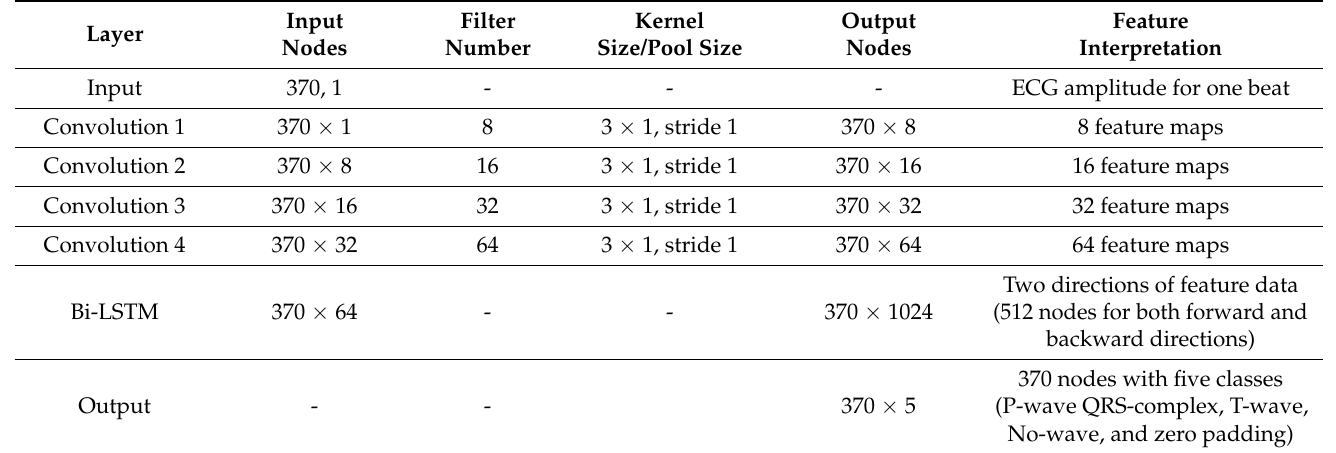
Table 3. The structure of the proposed CNNs-Bi-LSTM architecture.